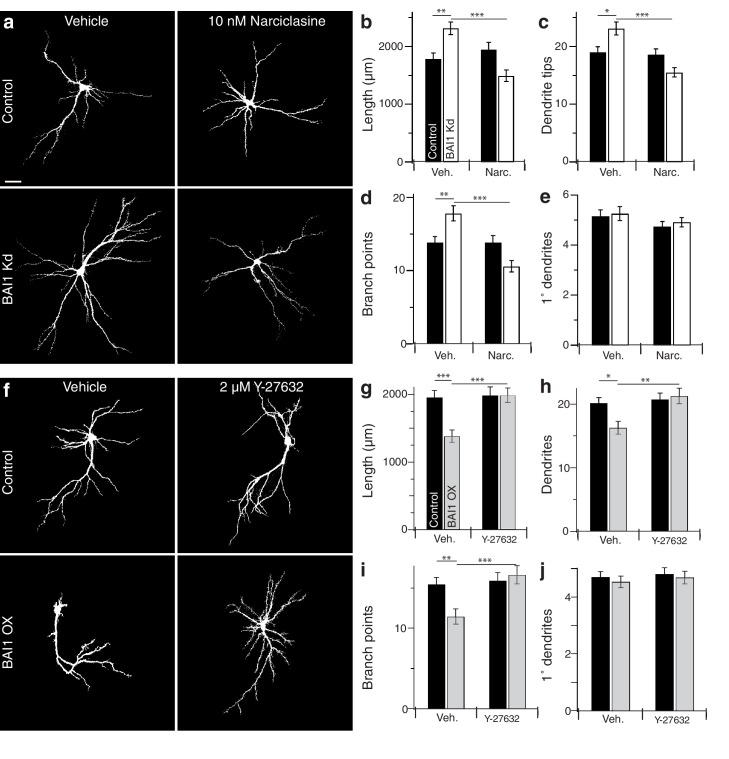
BAI1 manipulations are rescued by compensatory changes in RhoA signaling.(a) Representative somatodendritic images of hippocampal neurons transfected with EGFP alone (control) or with shRNA against Adgrb1 (BAI1 Kd) treated with vehicle or 10 nM narciclasine at 17 DIV and fixed at 21 DIV. Images are masked to remove axons and dendrites from other neurons. Bar is 20 µm. (b) Summary data for dendrite length. (c) Summary data for dendrite number. (d) Summary data for branches. (e) Summary data for primary dendrites. Total number of neurons: 105 per condition (N = 3). (f) Representative somatodendritic images of hippocampal neurons transfected with EGFP alone (control) or with BAI1 (BAI1 OX) treated with vehicle or 2 µM Y-26732 at 17 DIV, fixed at 21 DIV and masked as in panel a. g) Summary data for dendrite length. (h) Summary data for dendrite number. (i) Summary data for branch number. (j) Summary data for primary dendrite number. Total number of neurons: 47 per condition (N = 4). Data are represented ± s.e.m. (***p<0.0001, **p<0.01, *p<0.05) Detailed statistics are found in Figure 4—source data 1.10.7554/eLife.47566.037Figure 4—source data 1.Statistical summary for Figure 4: ANOVA and key Tukey post-hoc tests and N and n values for Figure 4b–e,g–j.10.7554/eLife.47566.034Figure 4—source data 2.Individual measurements of arbor parameters for neurons treated with narciclasine and Y-27632 (Figure 4b–e,g–j).10.7554/eLife.47566.035Figure 4—source data 3.Individual measurements of narciclasine controls and Sholl analyses in narciclasine- and Y-27632-treated neurons (Figure 4—figure supplement 1b–g).10.7554/eLife.47566.036Figure 4—source data 4.Individual measurements of spine parameters in neurons treated with narciclasine (Figure 4—figure supplement 1b–e).